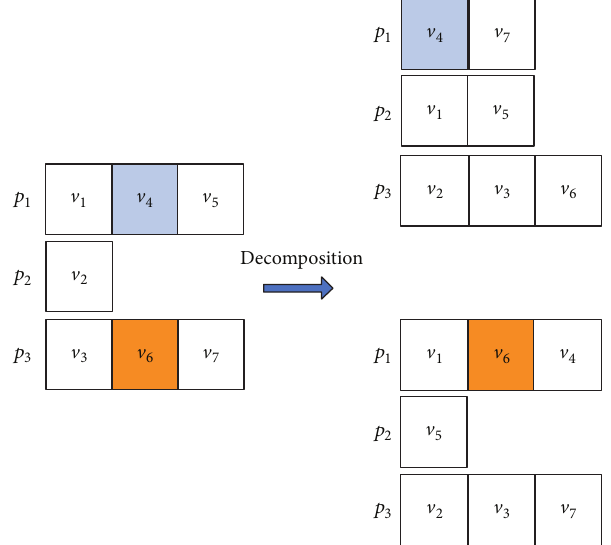
Figure 7: Illustration of the task-to-computing-node mapping for